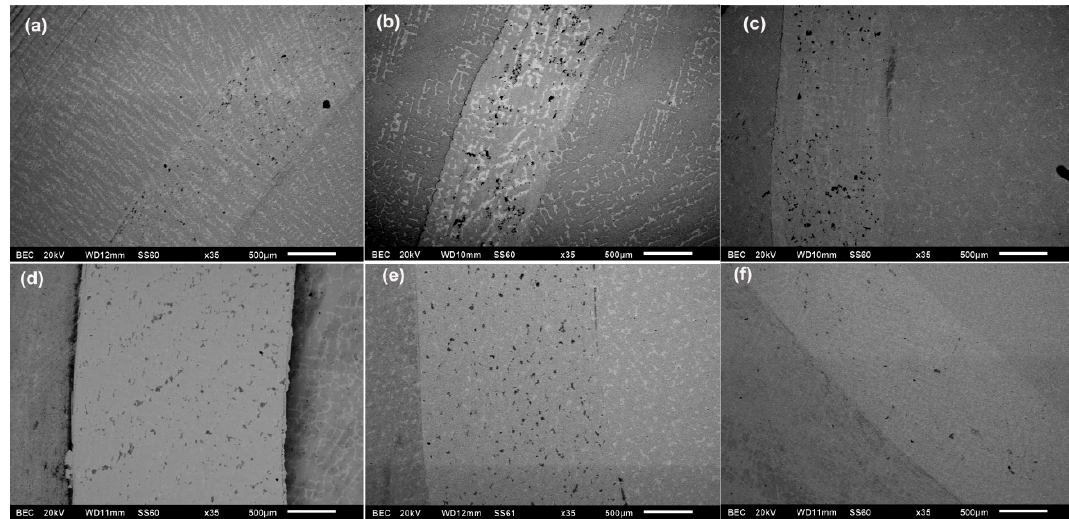
Figure 6. Wear tracks in different samples; ( a ) 0.25B-AC 4 km, ( b ) 0.25B-HT 4 km, ( c ) 0.5B-AC 4 km, ( d ) 0B-AC 12 km, ( e ) 0.06B-HT 12 km, ( f ) 1B-HT 12 km.